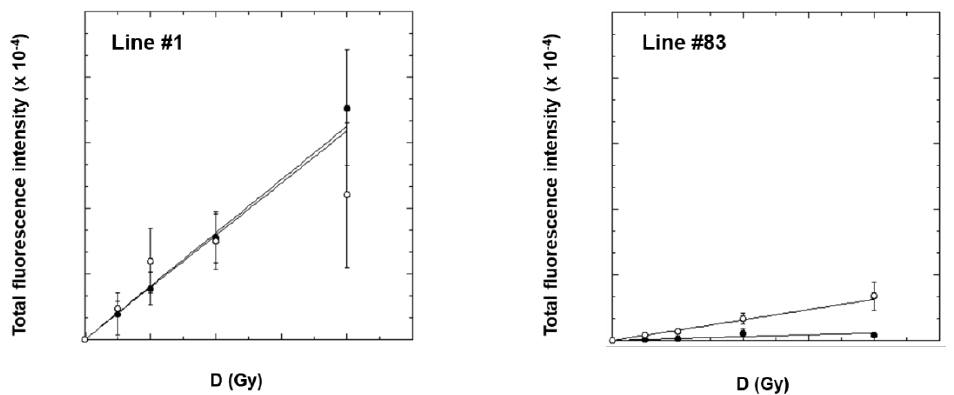
Figure 3. Dose–response curves for γ -H2AX induction (as measured as γ -H2AX immunofluorescence intensity) in GSC line #1 and line #83, 2 h after irradiation with FFF beams at different dose rates: 4 Gy/min (solid circle), 24 Gy/min (open circle). The error bar represents the standard error of the mean. Immunofluorescence intensity values in unirradiated cells (namely ~4.0 and ~2.1 a.u. for line #1 and line #83, respectively), have been subtracted from the values of irradiated samples. The dose–response curves for line #1 show the same slope at the two dose rates, i.e., (2.40 ± 0.40) × 10 4 Gy −1 For line #83, a big difference was found instead; the slope at 24 Gy/min was much higher than that at 4 Gy/min (i.e., (0.47 ± 0.06) × 10 4 Gy −1 and (0.08 ± 0.02) × 10 4 Gy −1 , respectively).